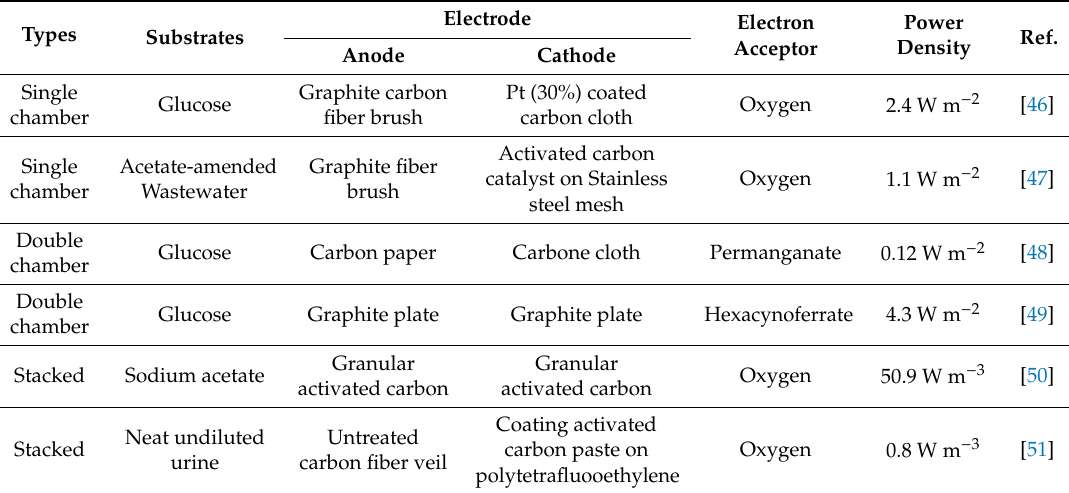
Table 1. MFC performance relative to